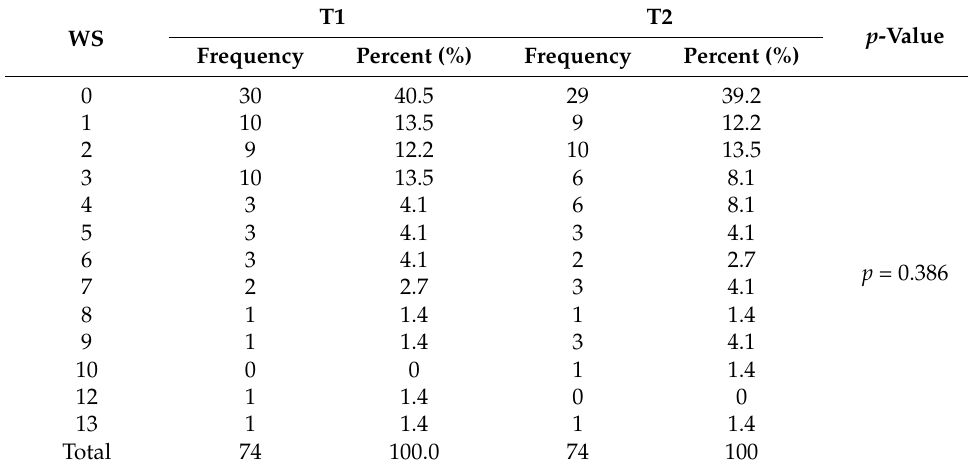
Table 2. Prevalence of WS at T1 and T2.